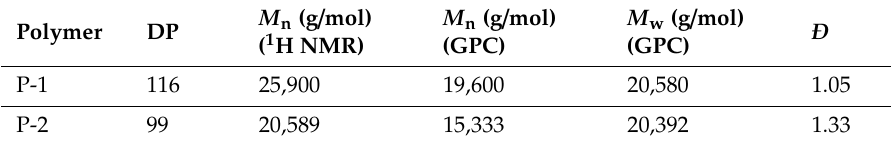
Table 1. Polymer characterization of P-1 and P-2.